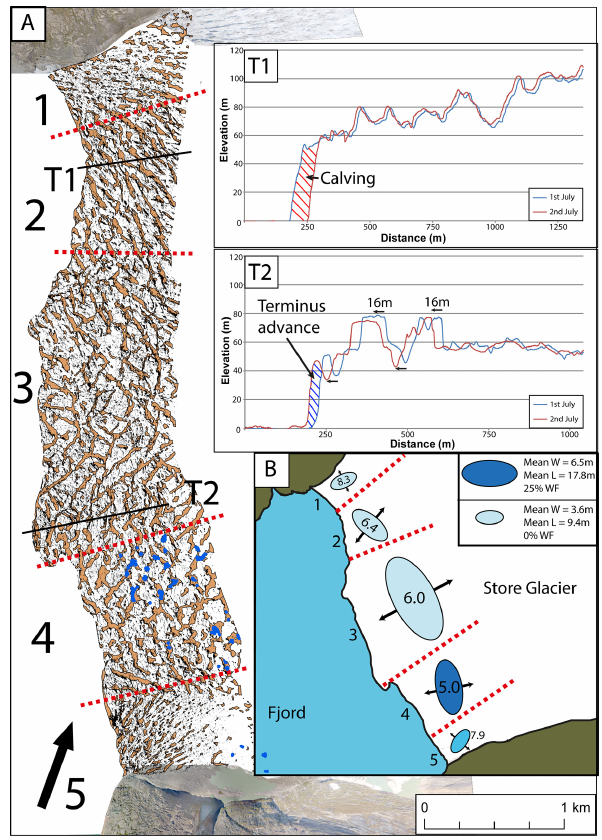
Figure 6. (a) Distribution and patterns of crevasses on Store Glacier. Dry crevasses, which are large structural features, are shown in or- ange. Narrower crevasses that are observed in the orthorectified im- ages but whose 3-D geometry is not constructed are shown in black. The areas of water-filled crevasses are shown in blue and occur al- most exclusively in zone 4. The regions of the terminus discussed are designated by the dotted red lines and are referred to as the black numbers. Transects 1 and 2 shown in the inset demonstrate how crevasses adverted downstream between 1 and 2 July. In T1, a series of calving events occurred which are discussed as calving event A. In T2, the calving front advanced 16m. (b) Illustration of the terminus of Store Glacier with ellipsoids proportional to the av- erage length, width and orientation of crevasses shown in (a) for the respective zones. The colour of the ellipsoids represents the propor- tion of crevasses that are water filled in each zone where WF refers to water filled in the legend. The italicised numbers denote the den- sity of crevasses per 10m 2 in each zone. Arrows illustrate inferred direction of principal